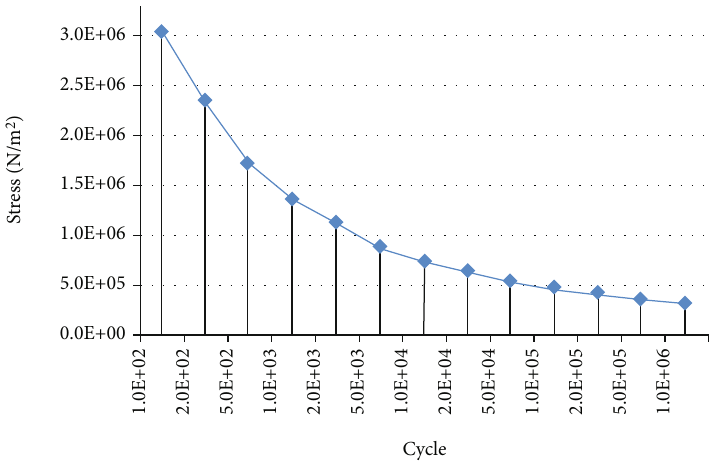
Figure 9: Meniscus S-N curve used for meniscus fatigue